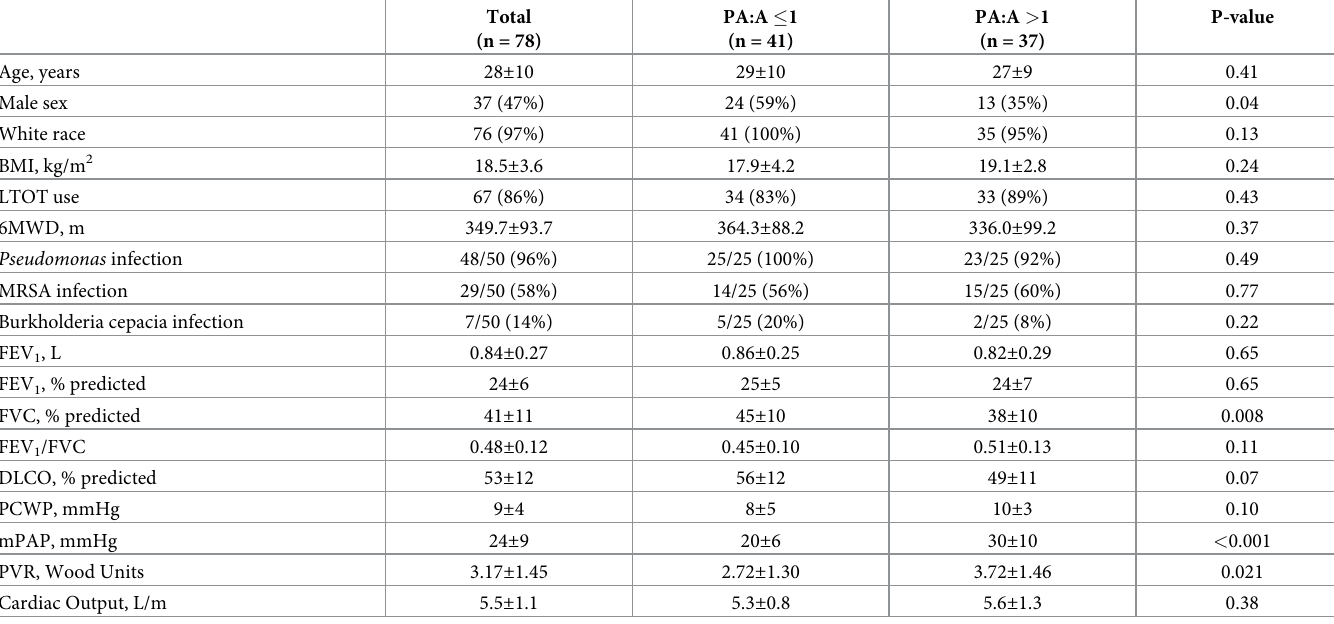
Table 1. Baseline